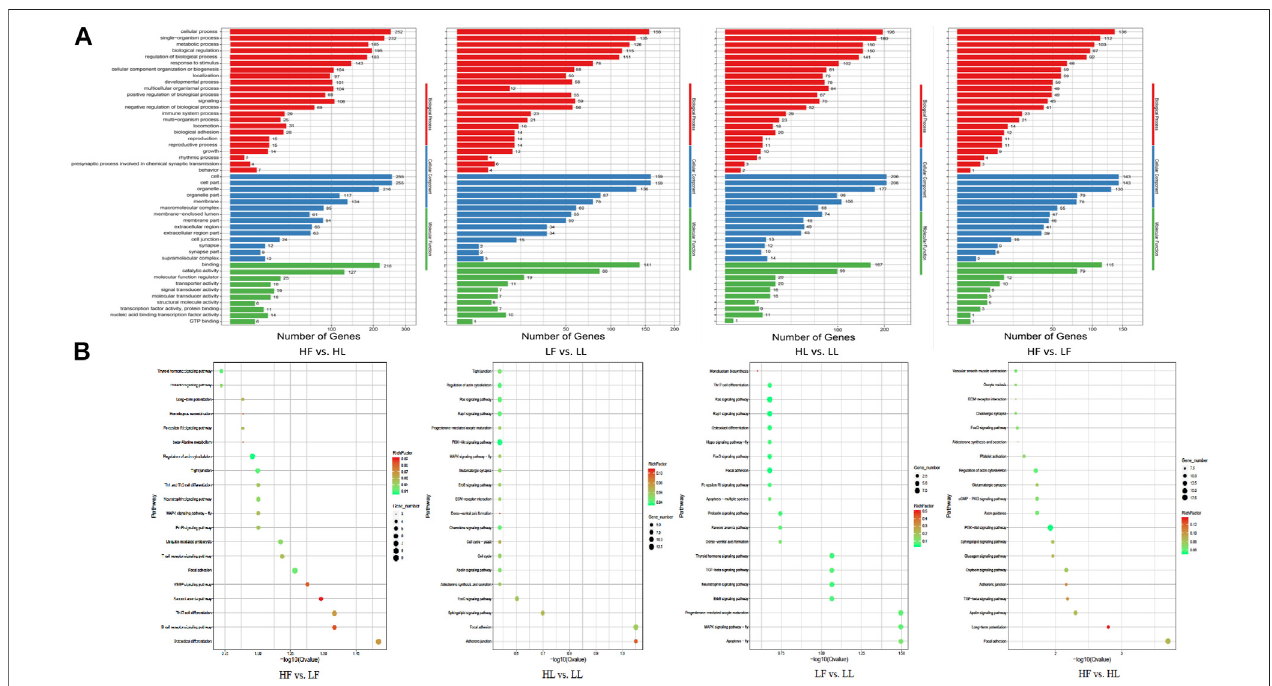
FIGURE 5 | GO and KEGG enrichment analysis of the host genes with DE circRNAs. (A) : The results of GO enrichment. (B) : The KEGG pathway enrichment.